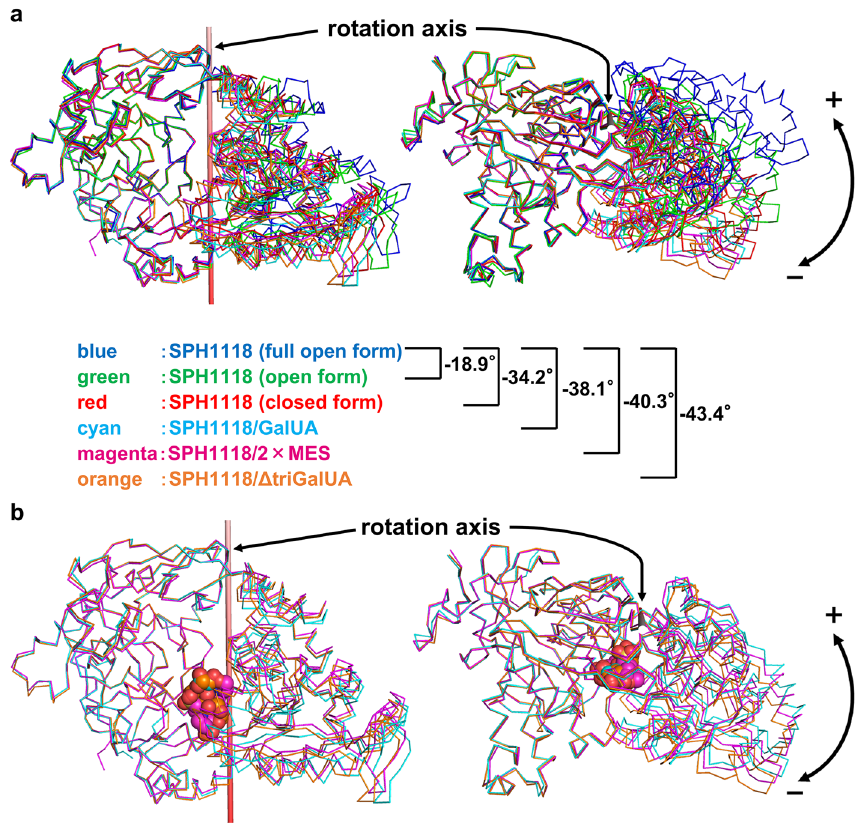
Figure 3. Conformational changes of SPH1118. ( a ) N terminal domains of ligand-free and -bound SPH1118 were superimposed. The right structure is rotated 90° toward the reader relative to the left one. Blue, SPH1118 (full open form); green, SPH1118 (open form); red, SPH1118 (closed form); cyan, SPH1118/GalUA; magenta, SPH1118/2 × MES; orange, SPH1118/ΔtriGalUA. Ribbon models show the main chains of SPH1118. (–) represents the direction in which the C terminal domain closes. Compared with the C terminal domain of SPH1118 (full open form), those of SPH1118 (open form), SPH1118 (closed form), SPH1118/GalUA, SPH1118/2 × MES, and SPH1118/ΔtriGalUA were closed by 18.9°, 34.2°, 38.1°, 40.3°, and 43.4°, respectively. ( b ) N terminal domains of ligand-bound SPH1118 were superimposed. The right structure is rotated 90° toward the reader relative to the left one. Ribbon and ball models show the main chain of SPH1118 and each ligand (GalUA, MES, and ΔtriGalUA), respectively. Cyan, SPH1118/GalUA; magenta, SPH1118/2 × MES; orange,